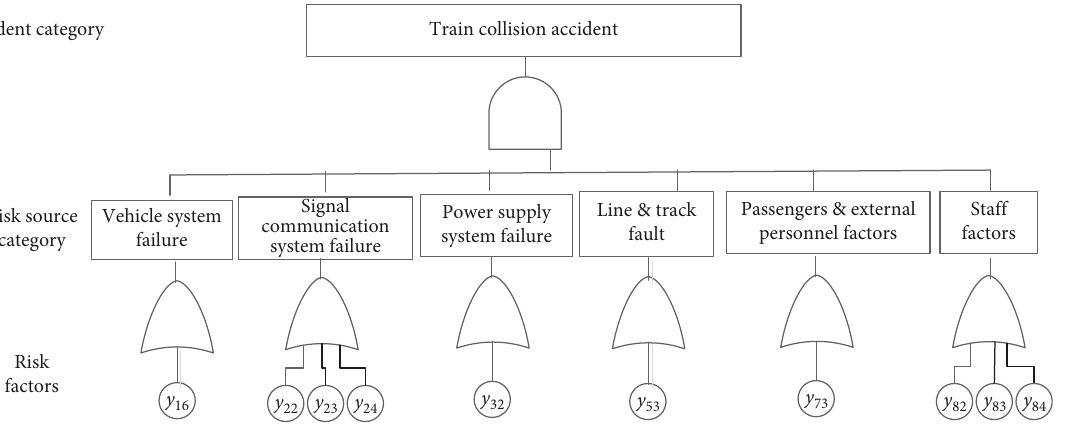
Figure 3: Fault tree analysis of train collision.